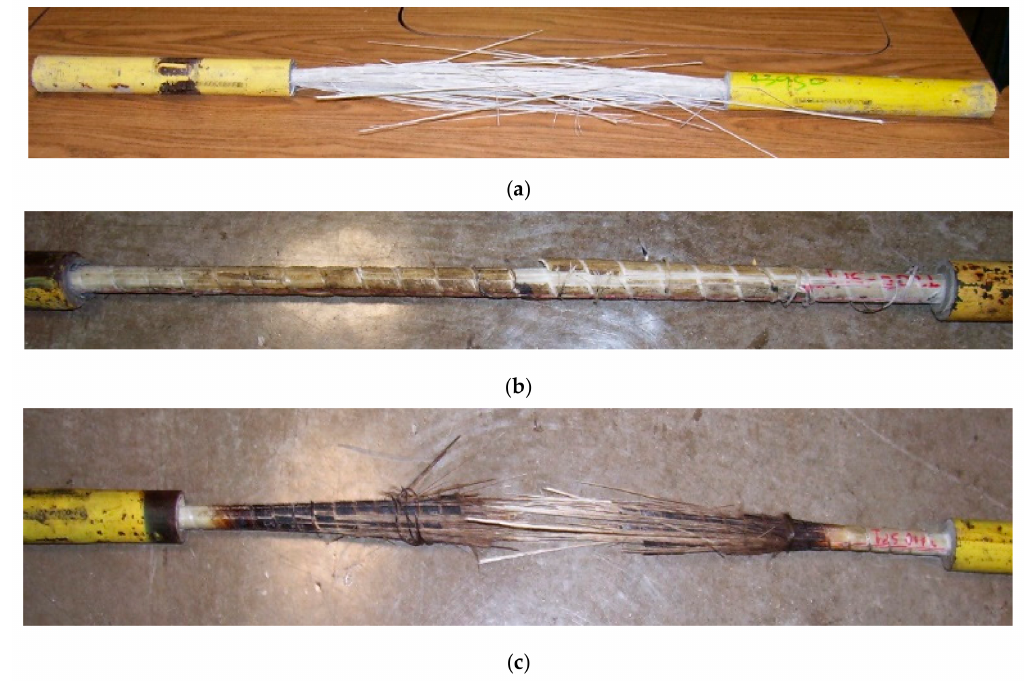
Figure 5. Tensile test specimens after failure: ( a ) T-A, ( b ) T-200, ( c )